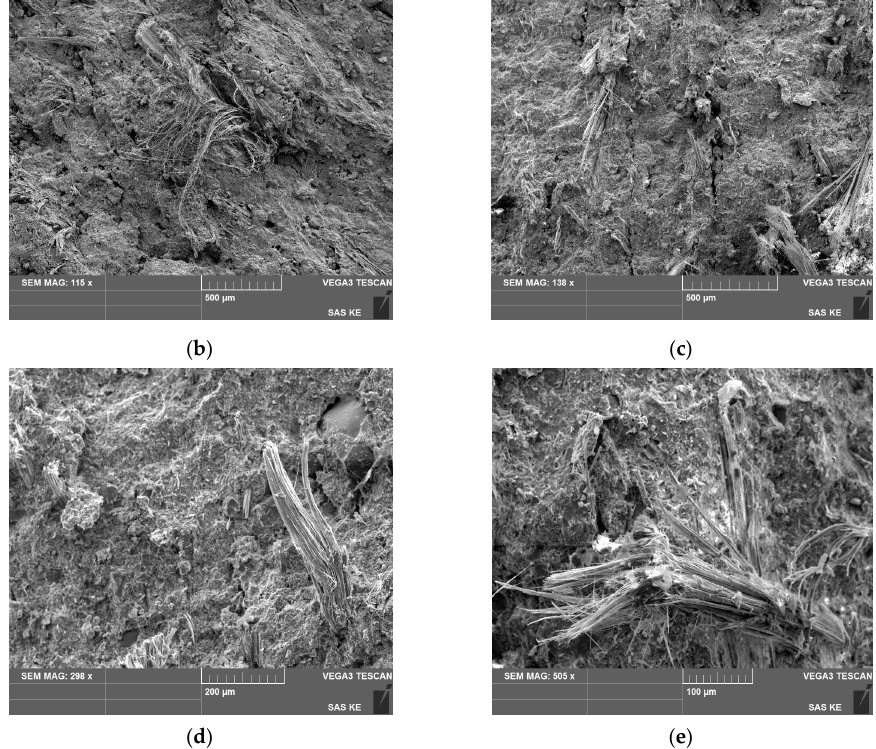
Figure 1. Scanning electron microscope (SEM) micrographs of the surface morphology of the